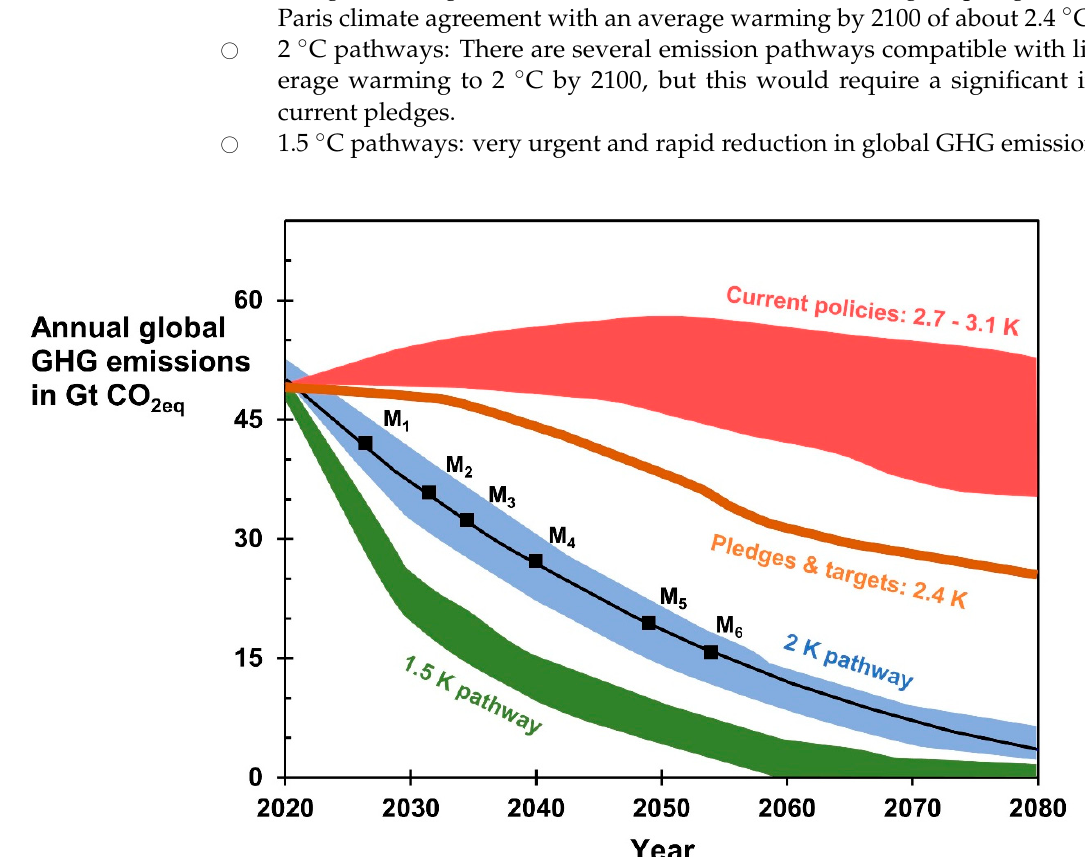
Figure 9. Range of future greenhouse gas emissions and global warming by 2100 published by Climate Action Tracker [28] and trajectory according to consecutive reduction measures M 1 to M 6 (reached in different years) consistent to keep temperature rise below 2 °C. It is thereby assumed that the population linearly increases from 7.8 billion in 2020 to 10 billion in 2050 (then constant).